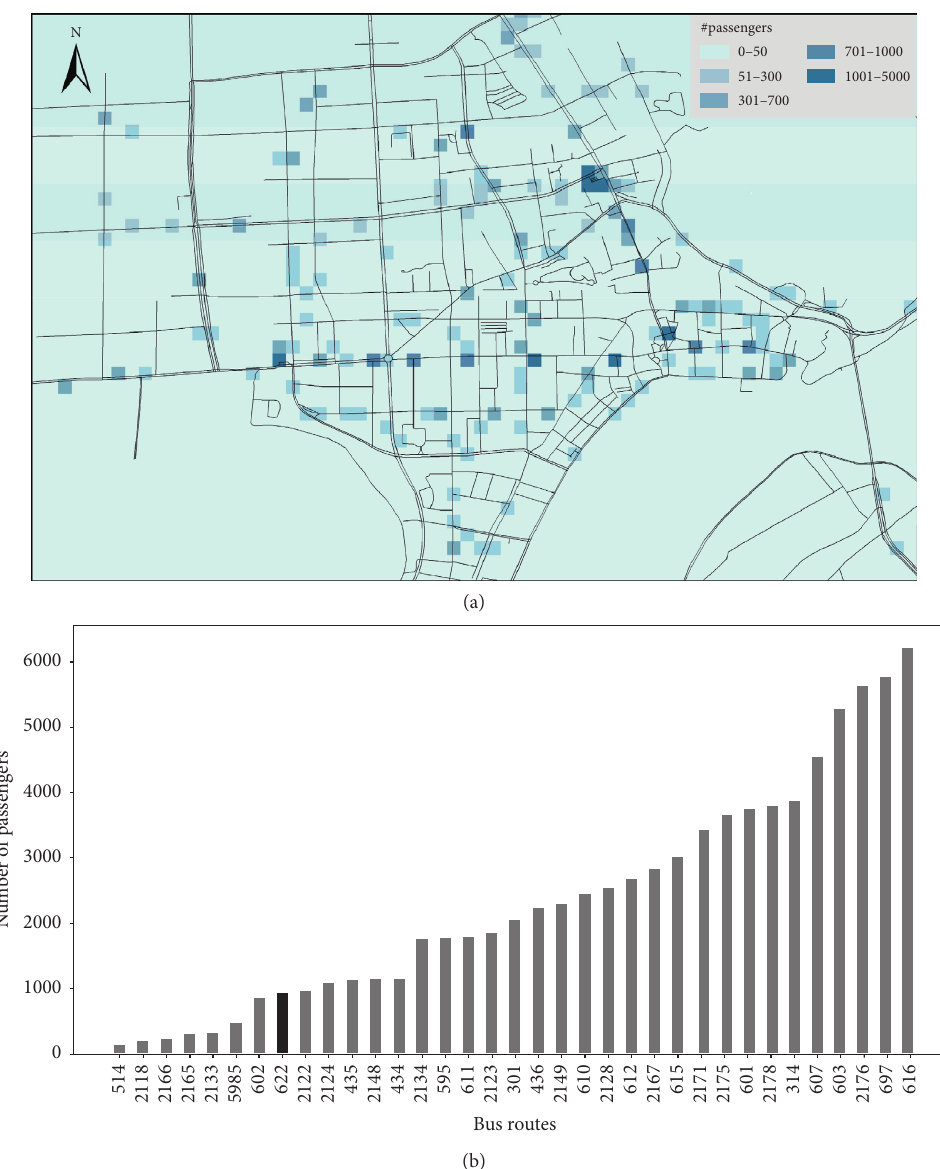
Figure 1: Bus travel demand in Fuyang, Zhejiang, China. (a) Spatial distribution of bus travel demand in Fuyang. (b) Bus travel demand by